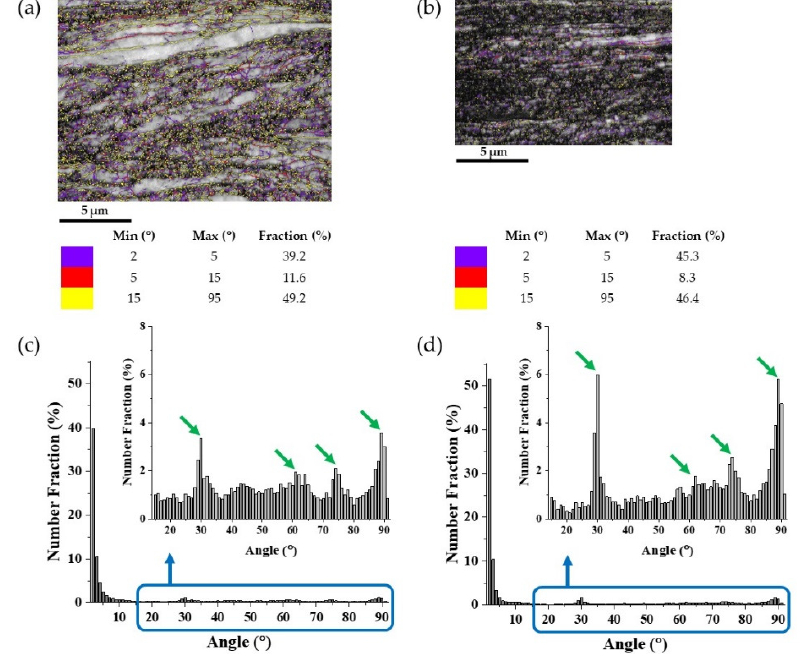
Figure 3. Boundary maps of ( a ) fine-grained BM and ( b ) ultra-fine-grained BM are shown with quantitative numerical values of GBCD of each. The misorientation angle distribution in ( c ) fine- grained BM and ( d ) ultra-fine-grained BM are plotted. The graphs show the misorientation angle ranges of 2 to 90°, and the inset graphs show the misorientation angles of 15 to 90° (enlarged plot of blue box areas).